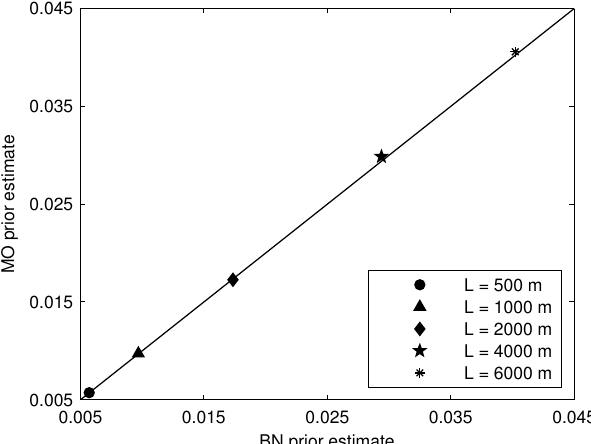
Figure 13. Comparison of BN and MO segment failure probability estimates (shown together with the 1:1 line, which represents perfect